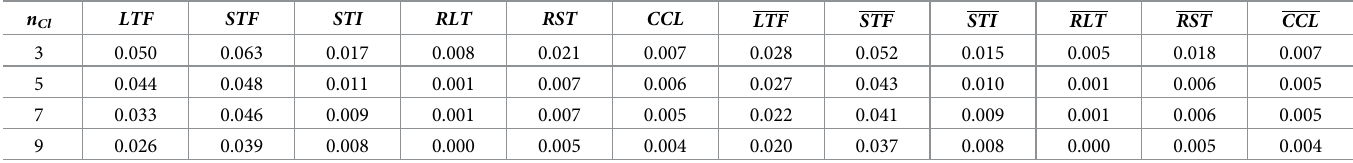
Table 9. Comparison of the average gap AvG for all algorithms according to the number of confidentiality level n Cl .